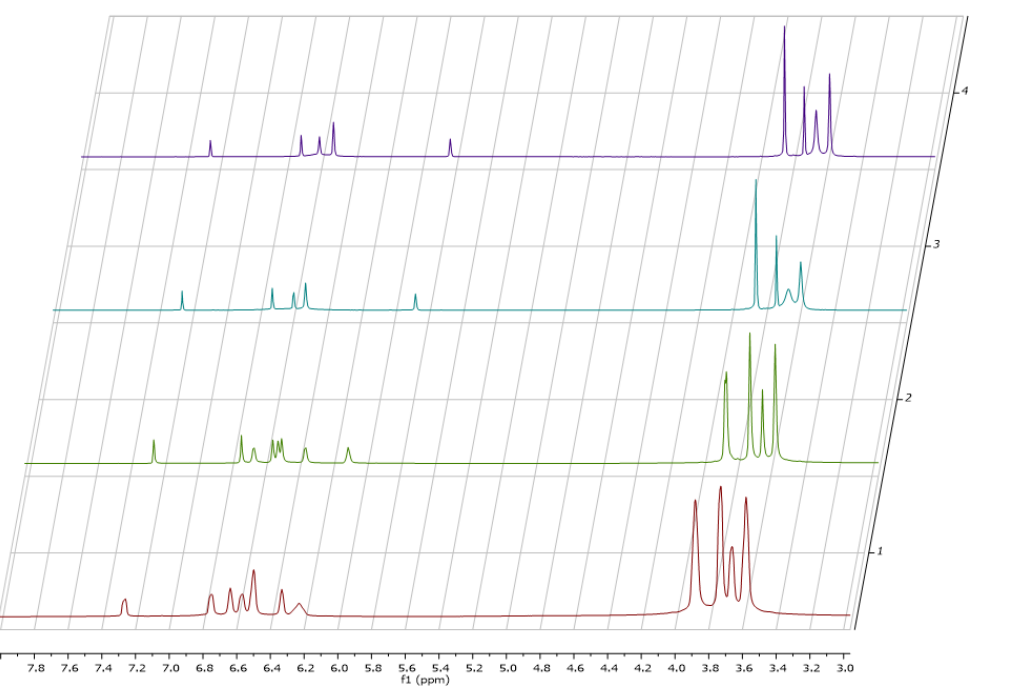
Figure 2. 1 H-NMR Spectra of the intermediate 15 ; temperatures: violet , 40 ◦ C; cyan , 27 ◦ C; green , − 30 ◦ C; red, − 50 ◦ C.